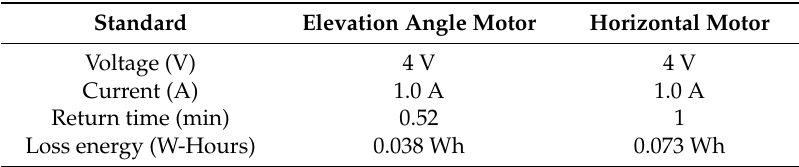
Table 7. Loss analysis of step